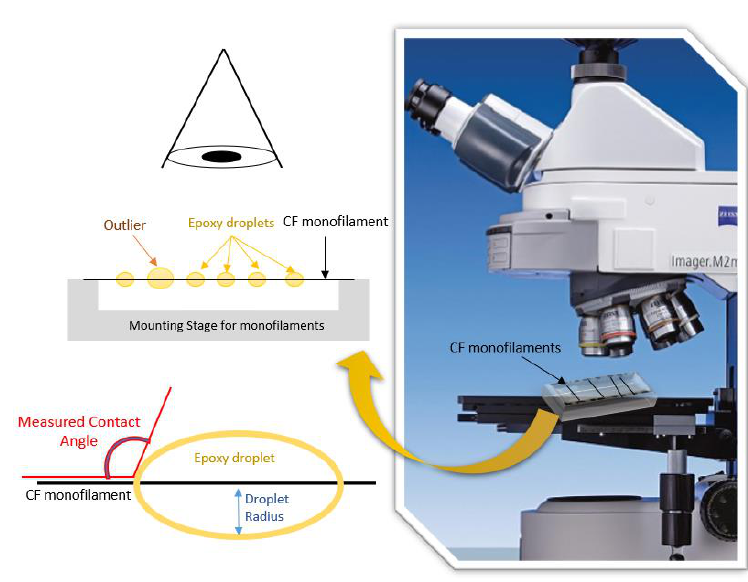
Figure 2. Contact angle measurement on CF monofilaments.